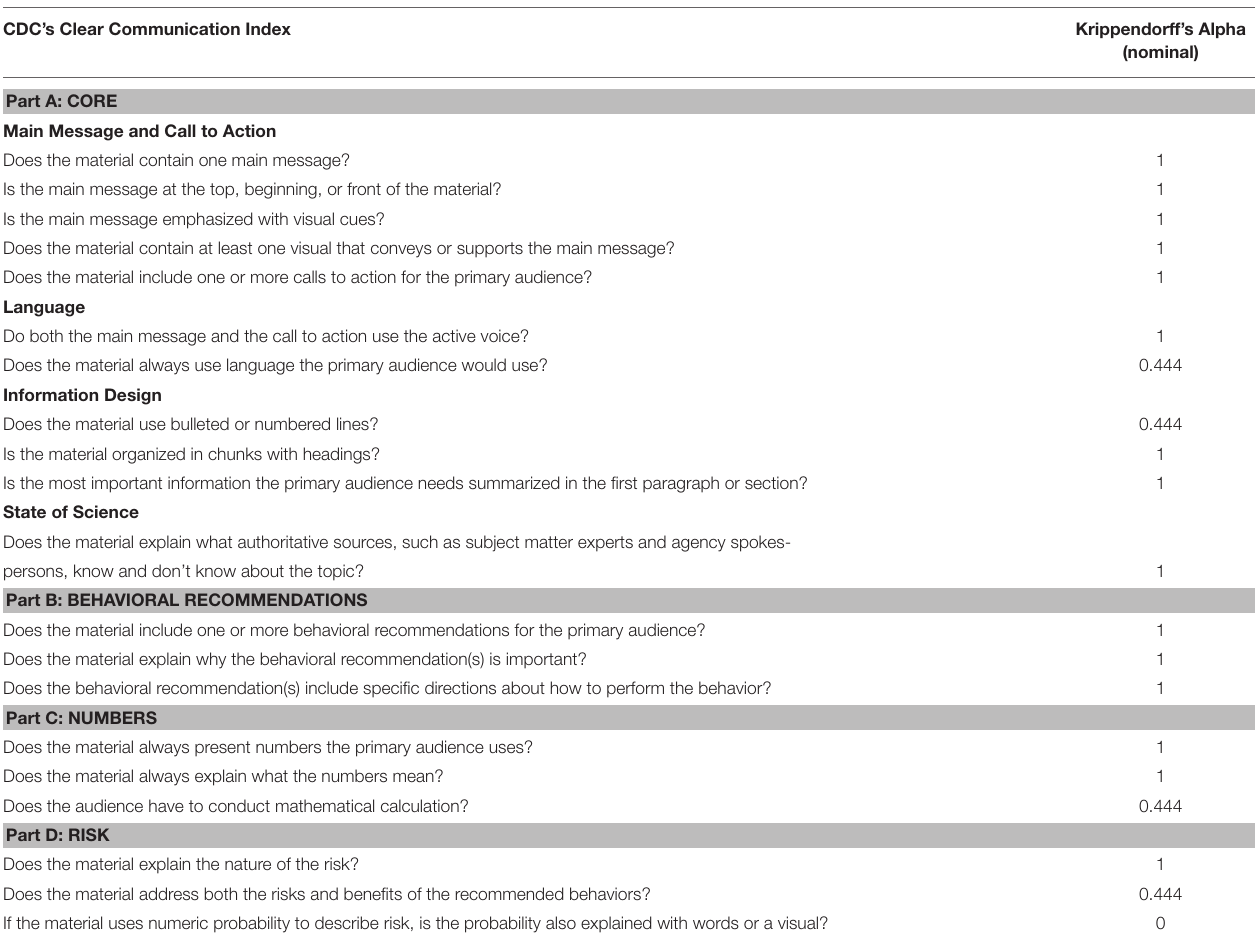
TABLE 6 | Total scores = 0.91 (20